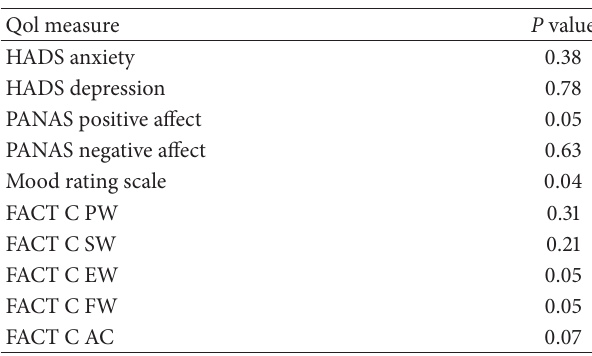
Table 3: Univariate analysis of preoperative Qol and survival.